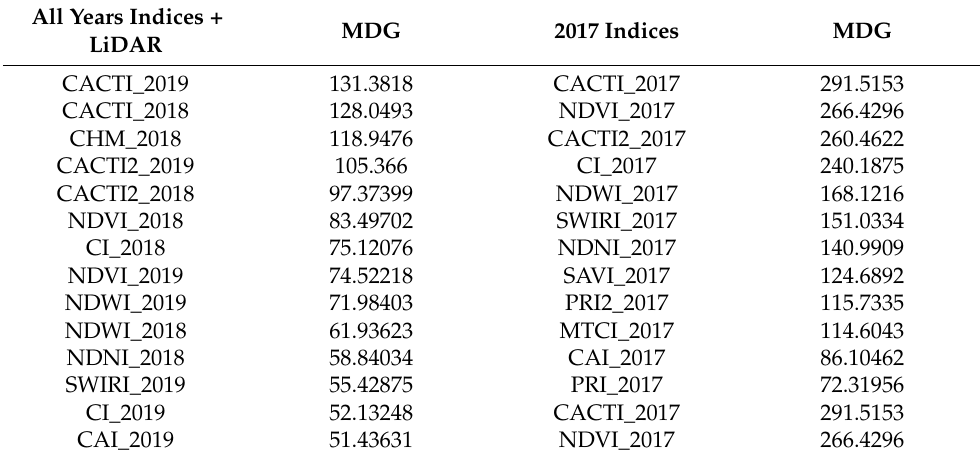
Table 5. MDG for classification iteration with the highest (All Years Indices + LiDAR) and lowest overall accuracy (2017